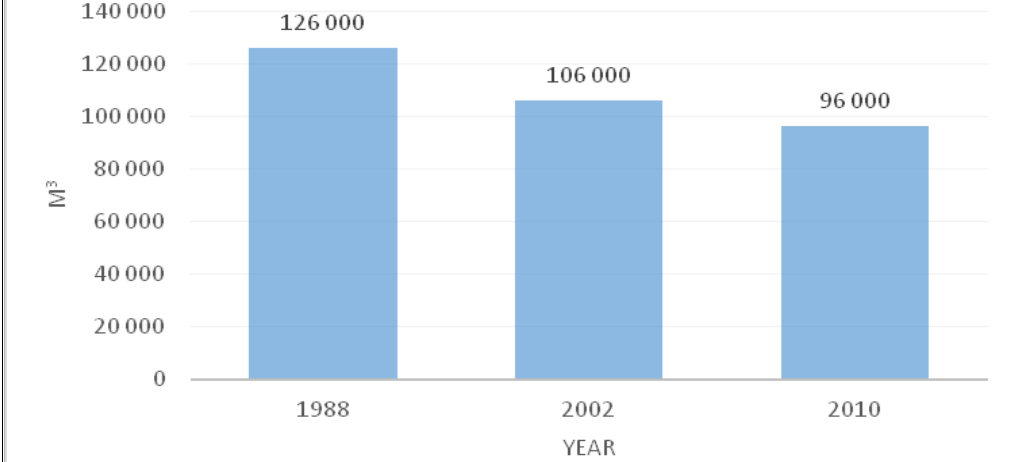
Fig. 4. Capacity utilization of wood(m 3 ) in the plywood industry in Nigeria (after Ogunwusi, 2014)